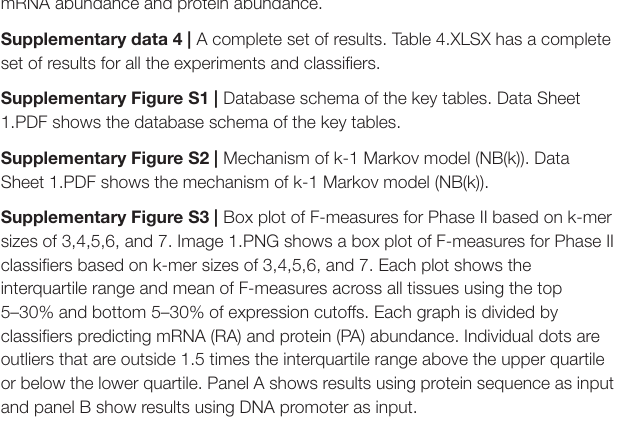
Supplementary Figure S4 | Box plot of F-measures for Phase II based on expression types with protein sequence. Image 2.PNG shows a box plot of